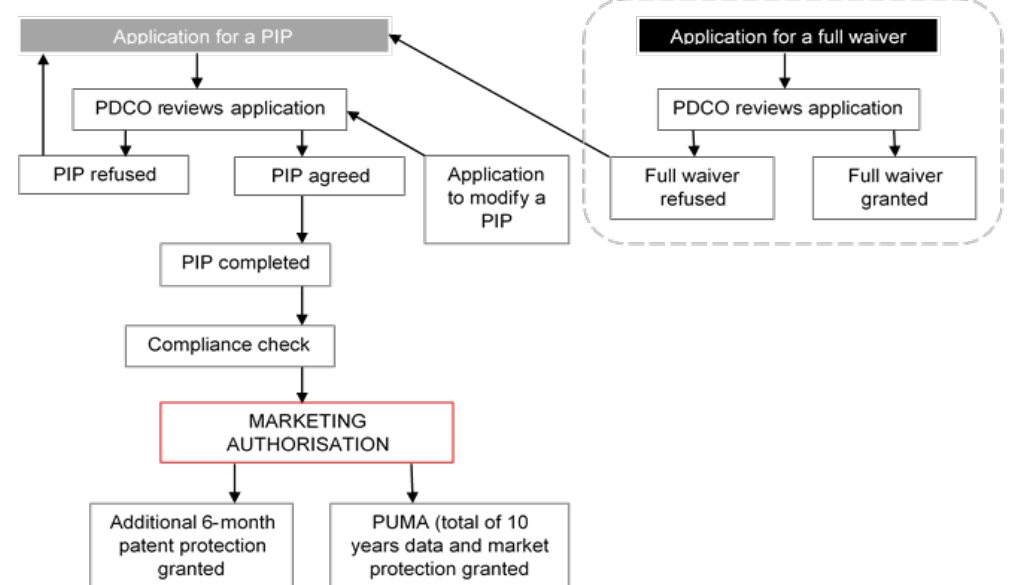
Figure 1. Overview of current paediatric investigation plan (PIP) application process. The flow